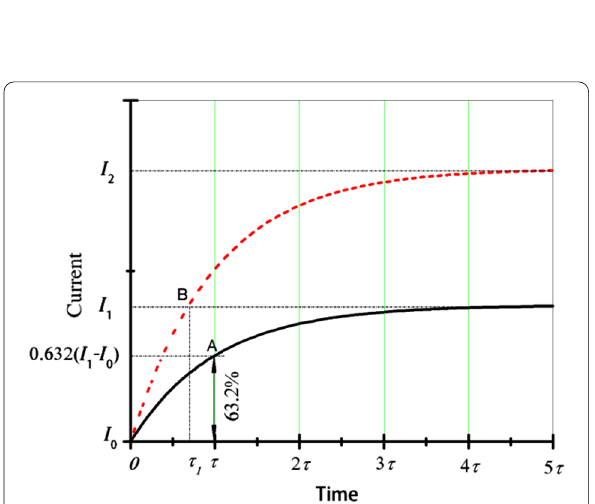
Figure 8 Principle of the real-time current-tracking